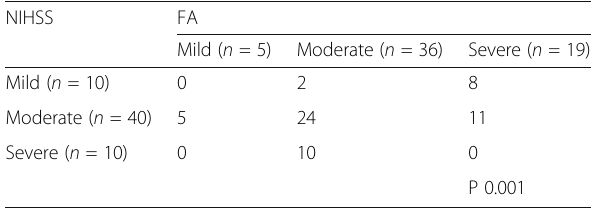
Table 1 Correlation between the degree of FA reduction and NIHSS on admission